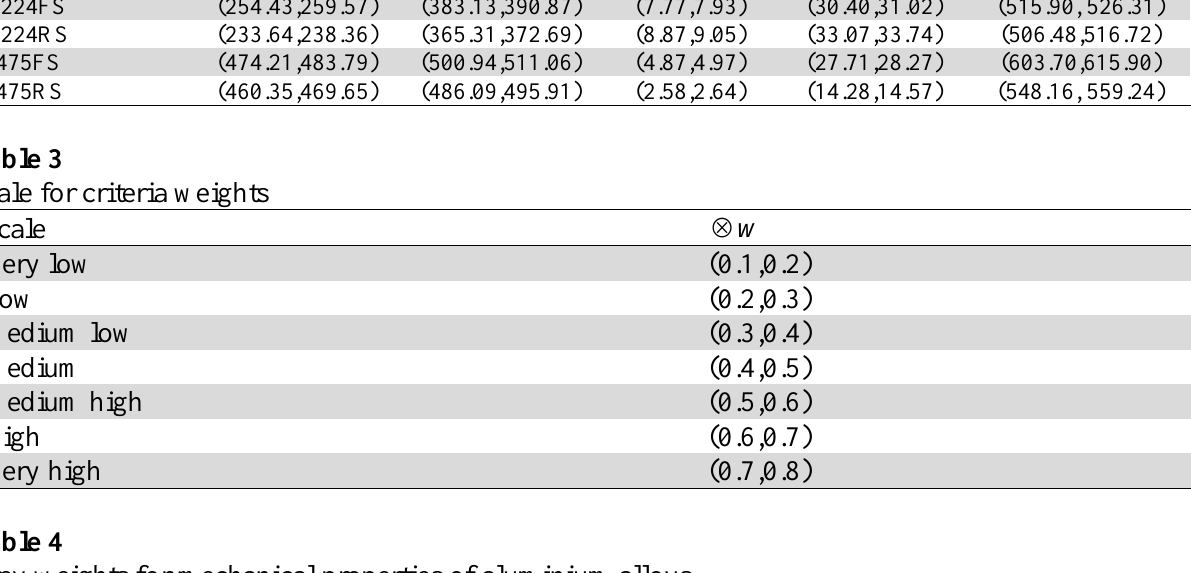
Grey weights for mechanical properties of aluminium alloys Criteria